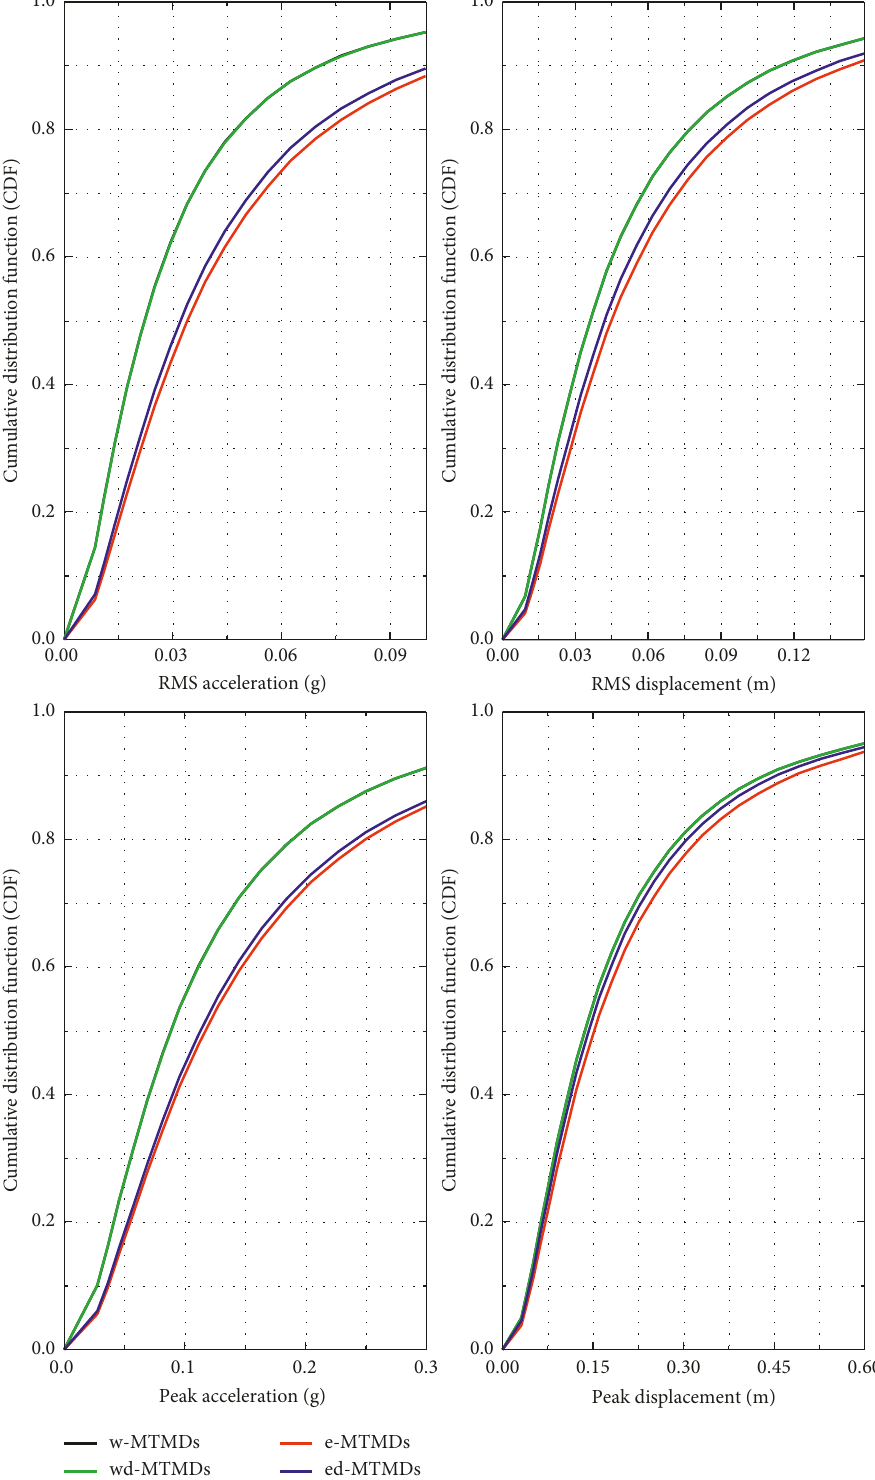
Figure 6: The CDF of responses for the w-MTMDs, e-MTMDs, wd-MTMDs, and ed-MTMDs subjected to wind